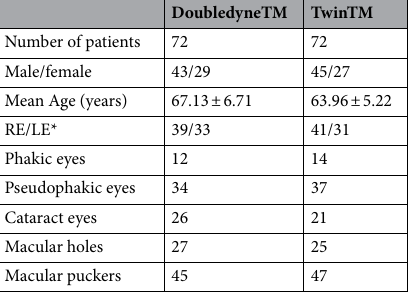
Table 1. Characteristics of groups of patients who underwent surgery using DoubledyneTM and TwinTM as a dye to perform peeling of the epiretinal membrane or the internal limiting membrane. * RE: right eye; LE left eye.